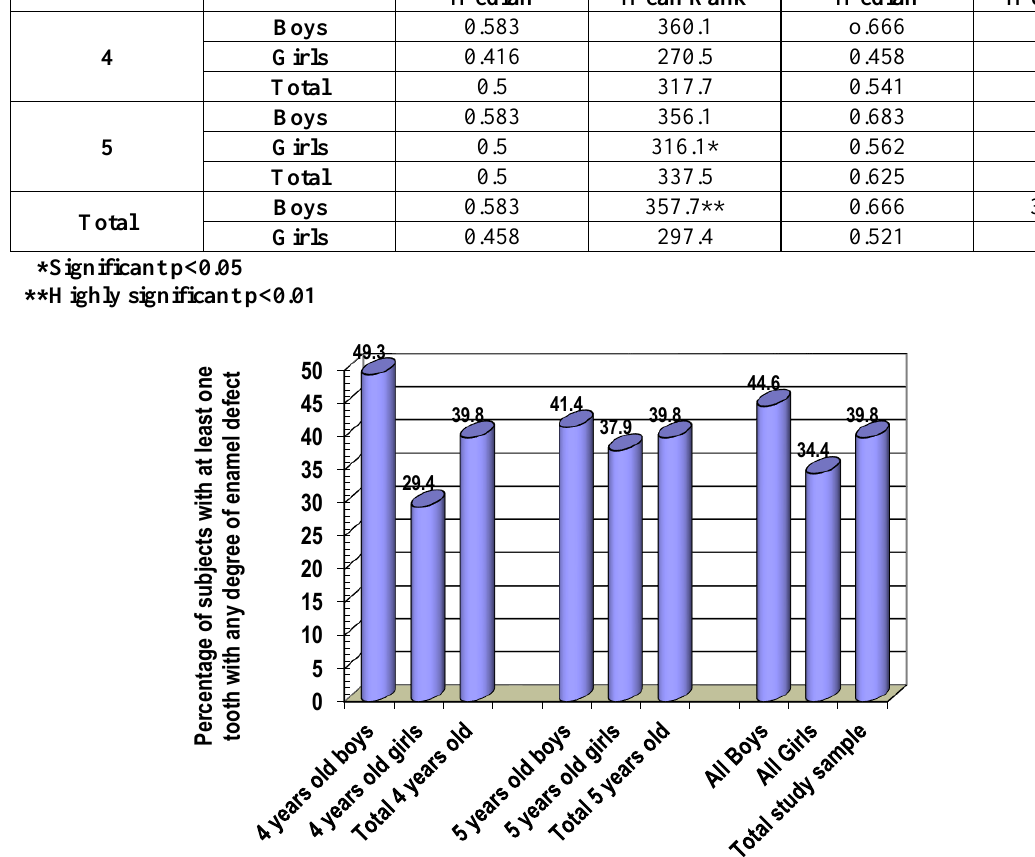
Figure 1: The distribution of children with enamel anomalies by age and